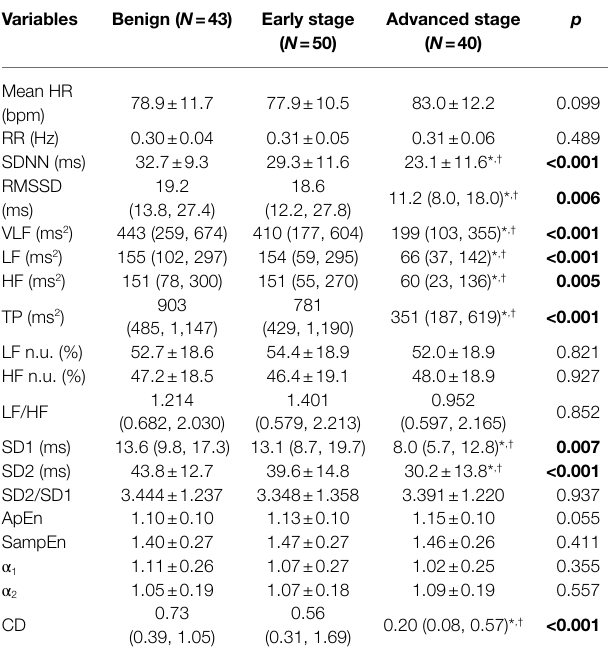
ApEn, approximate entropy; bpm, beats per minute; CD, correlation dimension; HF, high-frequency power; HR, heart rate; LF, low-frequency power; LF/HF, ratio of low-frequency power to high-frequency power; RMSSD, root mean square of successive interval differences; RR, respiration rate; SampEn, sample entropy; SD, standard deviation; SDNN, standard deviation of all normal-to-normal intervals; TP, total power; and VLF, very low frequency. Values are expressed as mean (SD) with normal distribution or median (Q1, Q3) without normal distribution. Bold values of p indicate statistical significance (value of p < 0.05). *p < 0.05 advanced-stage group vs. benign group. † p < 0.05 advanced-stage group vs. early-stage